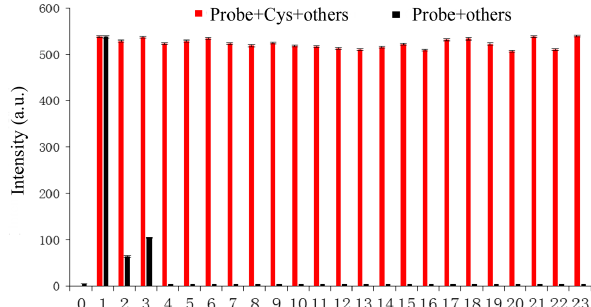
Figure 3. Black bar represents the fluorescence response of the probe (10 µ M) to various compounds (50 equiv.). Red bar represents the fluorescence response of the probe (10 μ M) to Cys (50 equiv.) in the presence of other compounds (50 equiv.). Each reaction was in buffered solution (PBS:DMSO = 6:4, pH = 7.4) at room temperature. The numbers represent analytes: 0. Blank; 1. Cys; 2. Hcy; 3. GSH; 4. Asp; 5. Val; 6. Glu; 7. Pro; 8. Gly; 9. Phe; 10. Met; 11. Thr; 12. Ser; 13. Ile; 14. His; 15. Phe; 16. Lys; 17. Try; 18. Leu; 19. Cys C; 20. CN − ; 21. SCN − ; 22. HS − ; 23. SO 4 2 − . λ ex = 325 nm, λ em = 450